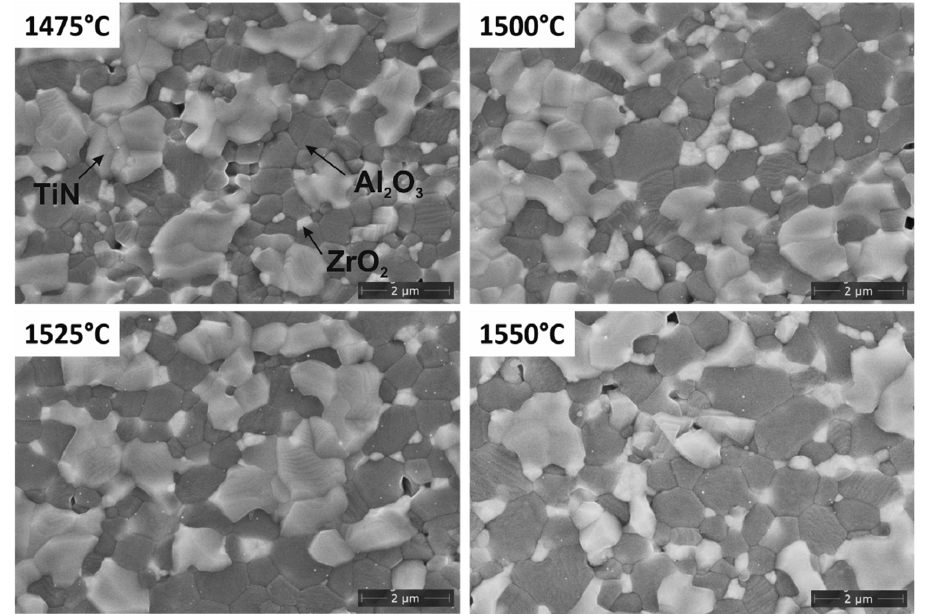
Figure 1. SEM images of polished and thermally etched ZTA-TiN composites sintered at different temperatures, dark grains are Al 2 O 3 , small light grains are ZrO 2 and medium grey is TiN.